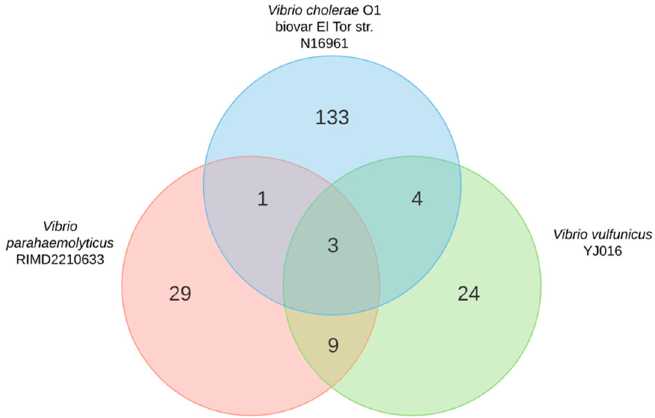
Figure 1. Venn diagram of small regulatory RNAs (sRNAs) reported for three human pathogenic Vibrio species in the Bacterial Small RNA Database.